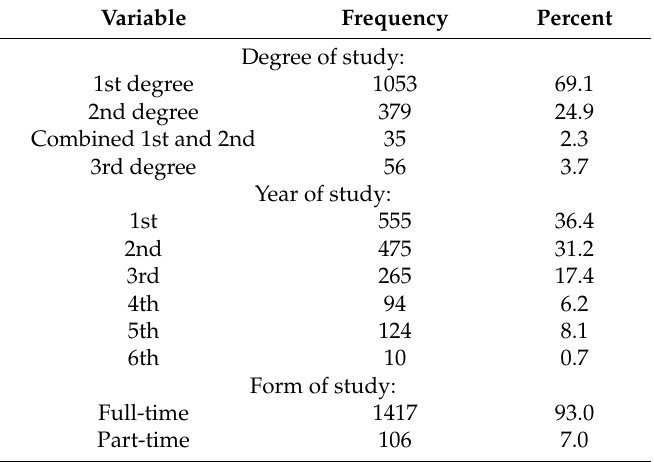
Table 1. Frequency analysis of the research